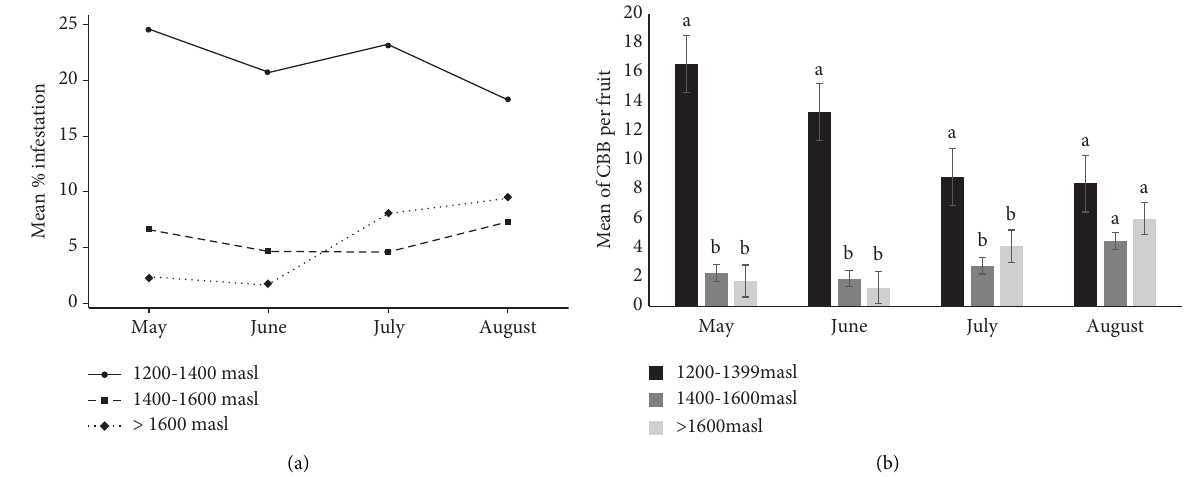
Figure 4: Monthly changes in (a) infestation and (b) CBB per fruit according to altitude. Te letters above bars indicate statistical diferences between CBB per fruit means (means separations test are independent for each